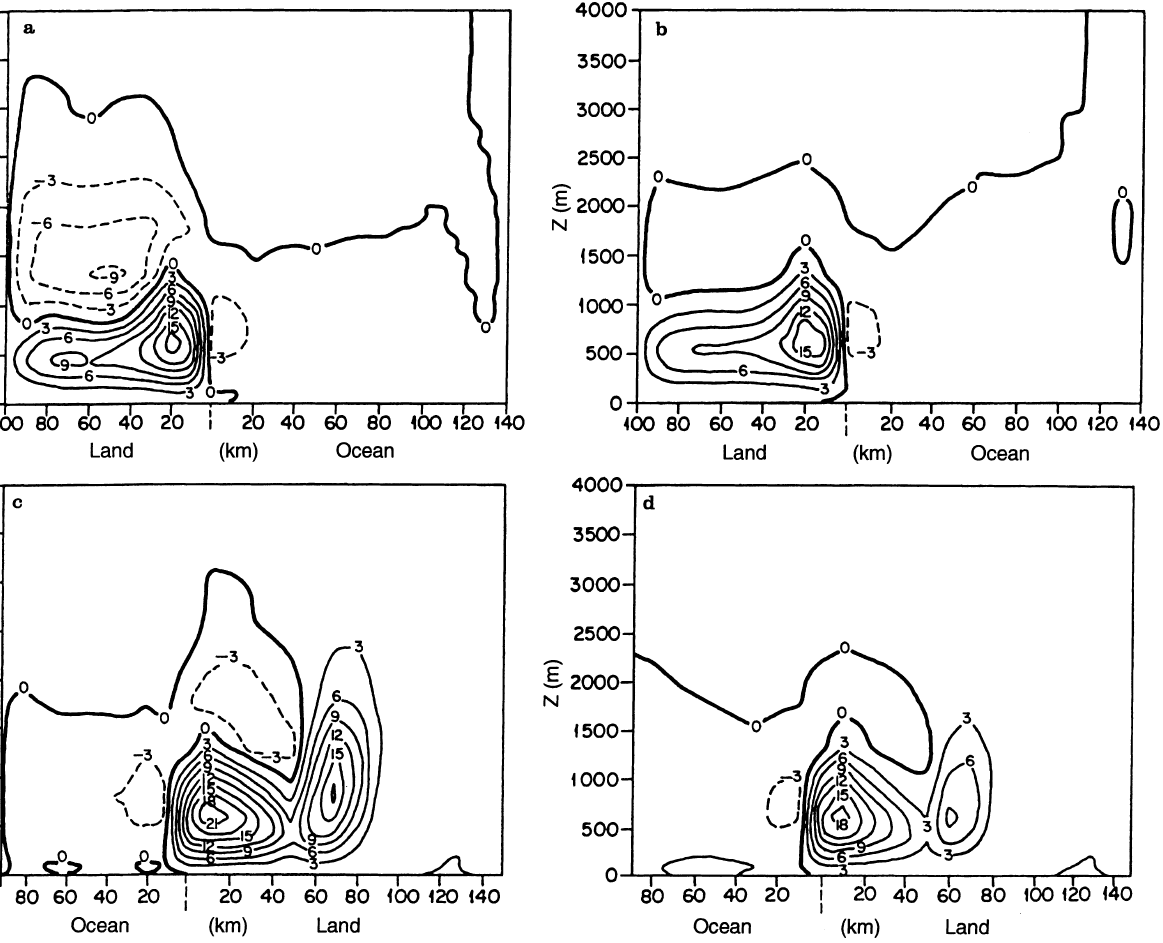
AMJ; c SN variation of w along a line parallel to CD (Fig. 1) situated 5 km west ward from the SN coastline for OND; and d same as c , except for AMJ. Units are cm s (cid:255) 1